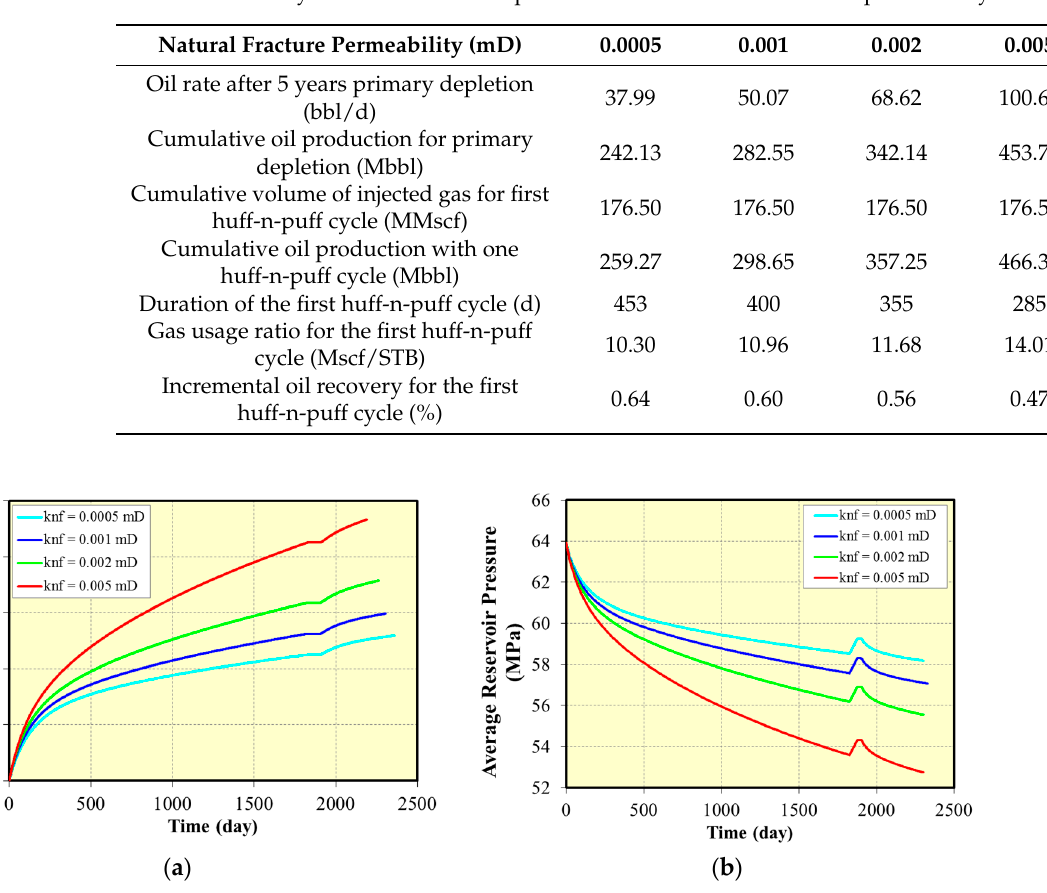
( b ) Figure 16. Correlation between natural fracture permeability and huff-n-puff results: ( a ) Cumulative oil production and incremental oil recovery for different natural fracture permeability; ( b ) Duration of the first huff-n-puff cycle and gas usage ratio for different natural fracture permeability. 4.2. Effect of Hydraulic Fracturing Parameters 4.2.1. Half-length of Hydraulic Fractures Fracture half-length of 35 m, 60 m, and 85 m were simulated to examine its effect on gas huff-n-puff. The results are shown in Table 13, and Figures 17 and 18. It can be seen from the figures: Long fracture half-length has a significant contribution in shale reservoirs by increas- ing oil production during primary depletion. When the same volume of gas was injected, fracturing could weaken the effect of gas injection, and with the increase of fracture half- length, the incremental oil recovery could be decreased. This is because the injected gas needs to seep along the long fractures to the far well area, reducing the gas injection effect. Compared with the long fractures, if there are micro-fractures in the near well area, the effect of gas huff-n-puff is better. The duration of the gas huff-n-puff cycle increases with the increase of fracture half- length. For long fracture half-length, the total volume of injected gas should be increased to improve the effect of gas huff-n-puff. Table 13. Summary of results for huff-n-puff with different half-length of hydraulic fractures. Half-Length of Hydraulic Fractures (m)